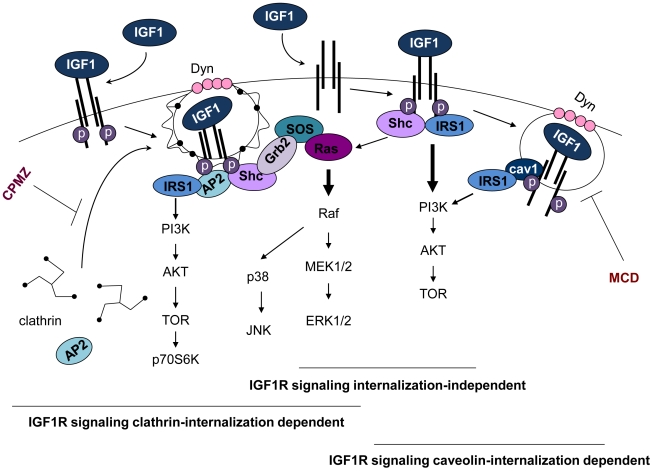
Simplified model for IGF1R signaling in ES.Globally, after ligand binding IGF1R can signal directly from the membrane (IGF1R signaling internalization-independent), with a major degree of IRS1/PI3K/AKT signaling activation and a smaller enhancement of the Ras/Raf/MEK/ERK signaling pathway, or, when internalized either by clathrin and/or caveolin-dependent mechanisms, it can signal from vesicles. In the case of clathrin-dependent endocytosis, IGF1R is recruited to CCPs through interaction of its cytoplasmic tails with the protein adaptor AP2, which in turn recruits clathrin to the plasma membrane and promotes its assembly into a lattice network. Through protein-protein interaction, clathrin and AP2 also bind several proteins of the endocytic machinery, such as dynamin, which regulates the fission of the CCPs with the consequent formation of CCVs, and GRB2, which recruits and binds the SOS protein and the IGF1R-phosphorylated protein Shc, activating the RAS/RAF/MEK/ERK and p38MAPK signaling pathways. To a lesser extent, it also activates the IRS1/PI3K/AKT signaling pathway. In the case of caveolin-dependent endocytosis, IGF1R is recruited to caveolae, promoting caveolin phosphorylation and the subsequent recruitment of dynamin, which promotes caveolar budding and the formation of cavicles. Cav-1 phosphorylation phosphorylates IRS-1, enhancing the activation of thePI3K/AKT signaling pathway. The thickness of the arrows indicates the prevalence of signaling pathway activation. CPMZ treatment inhibits the formation of CCP by inhibiting clathrin-heavy-chain conformations and MCB inhibits the formation of cavicles by depleting cholesterol, disrupting the caveolae.